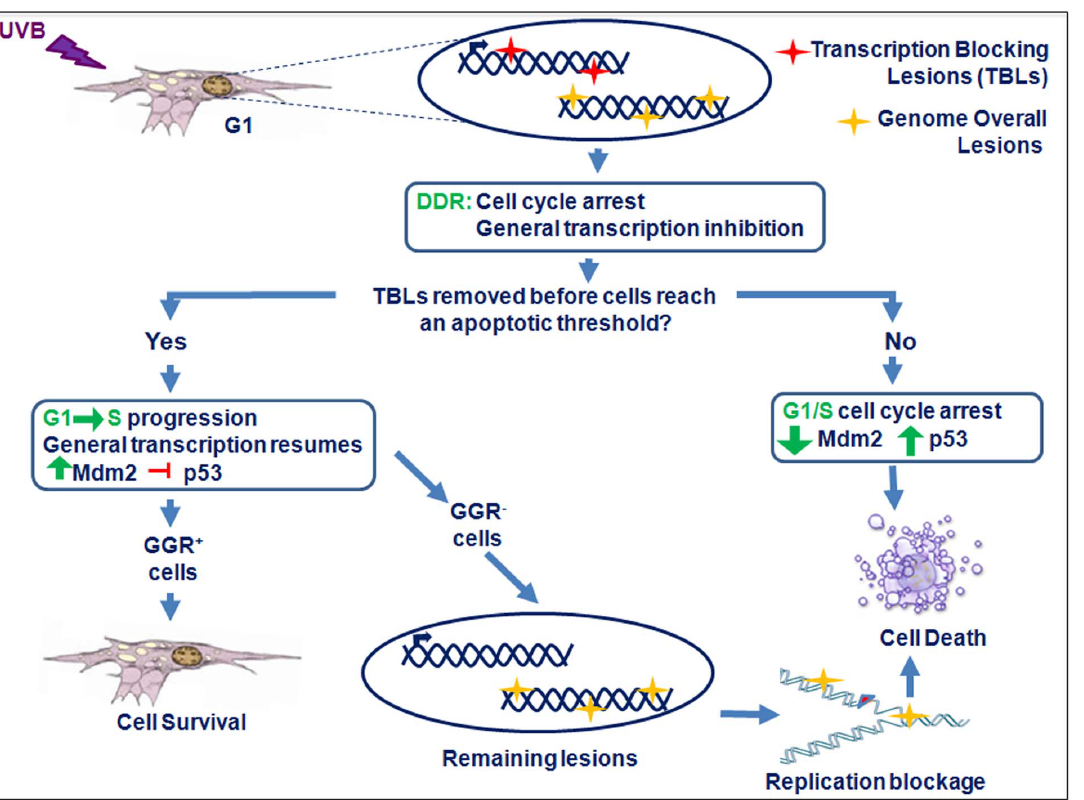
Figure 6. Proposed model for the different responses of human cells to UVB irradiation depending on their ability to remove DNA lesions. Upon UVB-irradiation of human fibroblasts synchronized in the G1 phase of the cell cycle, the presence of lesions on transcribed regions of the genome elicits the DNA Damage Response (DDR), comprising DNA repair, cell cycle arrest, and general transcription inhibition. In CS-B cells, the lack of TCR leads to low levels of Mdm2 and apoptosis induction. When DNA repair removes transcription blocking lesions (TBLs), Mdm2 counteracts p53 activation and cells are released to go through S-phase, and survive higher levels of lesions. In the case of XP-C (GGR 2 ) fibroblasts, however non- removed lesions lead to replication blockage and cell death, even in the presence of increased levels of Mdm2.